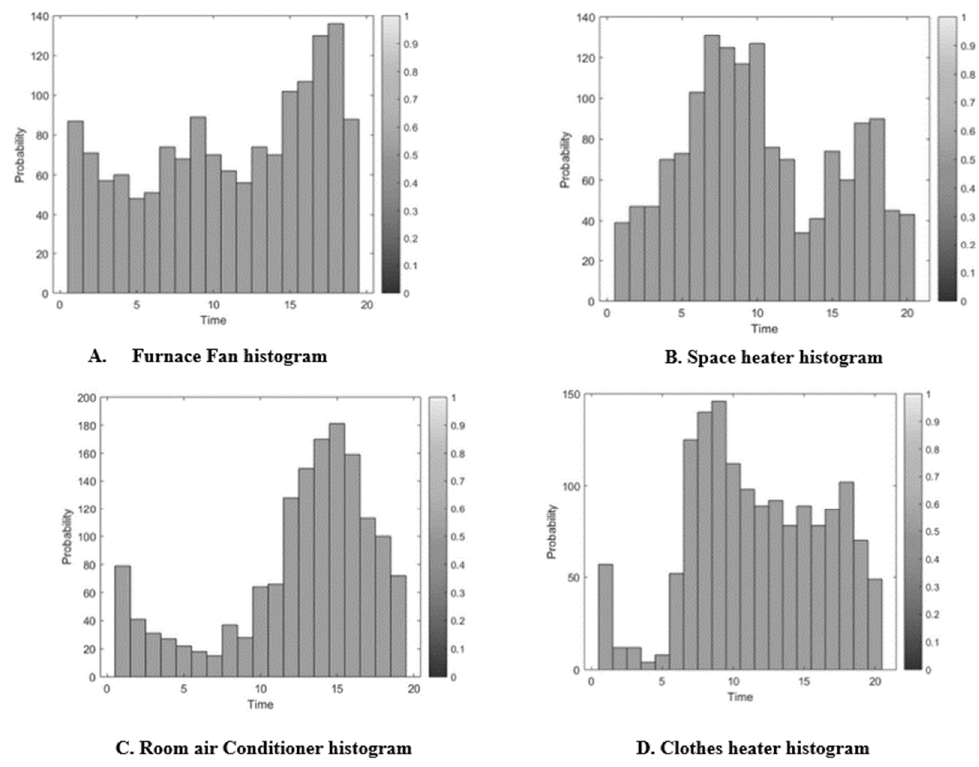
Figure 5. Household appliance histograms: ( A ) Furnace Fan, ( B ) Space Heater, ( C ) Room air Condi- tioner, ( D ) Clothes heater.